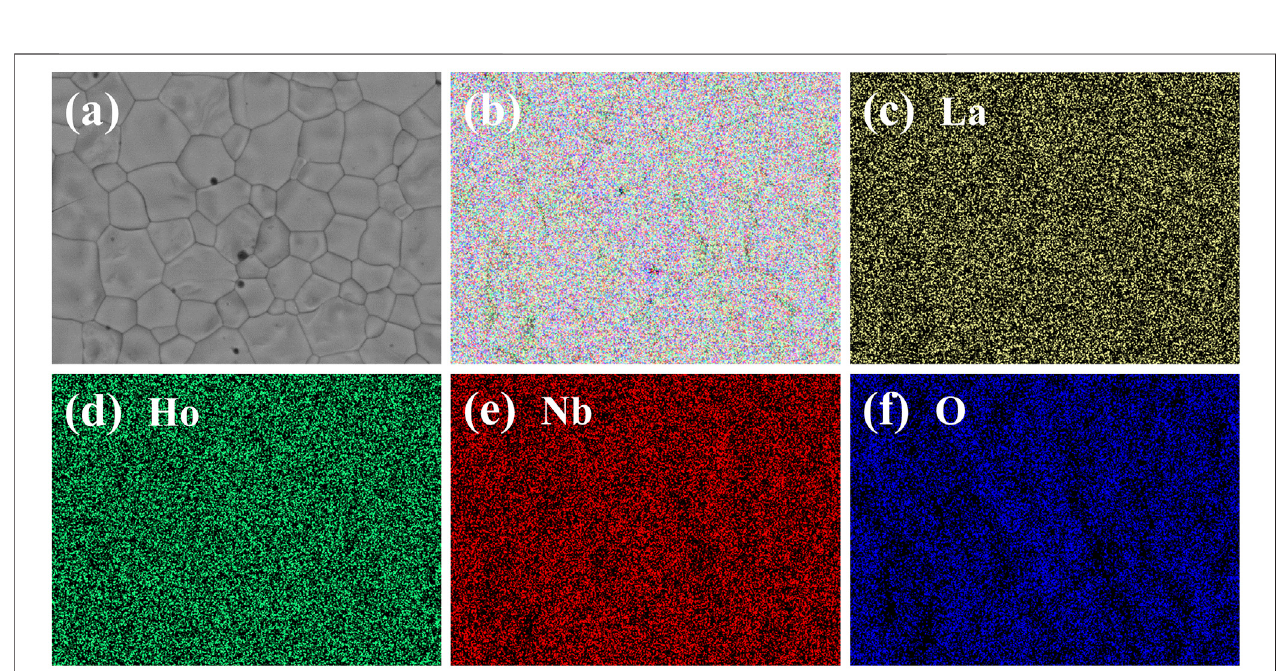
FIGURE 3 | SEM and EDS mapping photos of (La 3/6 Ho 3/6 ) 3 NbO 7 ceramics: (A) BSE photo and (B – F) element mappings.